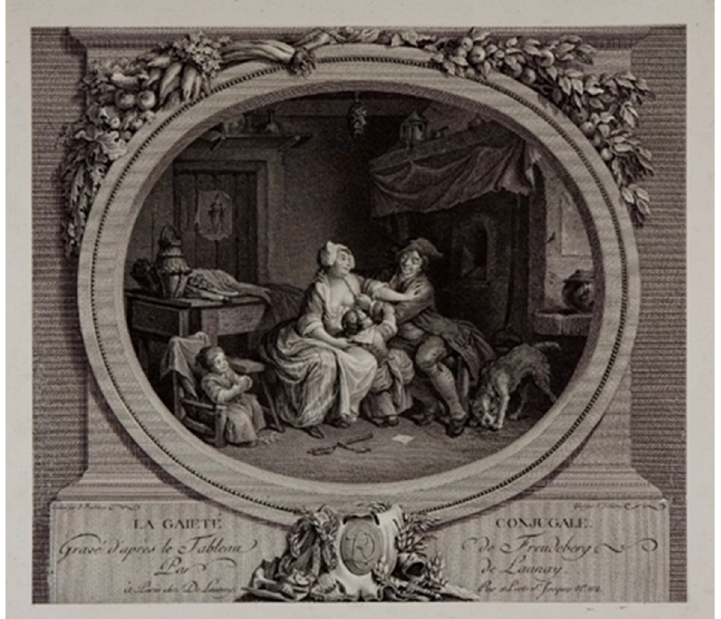
Figure 9. Nicolas Delaunay, after Sigmund Freudenberger (Switzerland 1745–1801), Conjugal Gaiety La gaieté conjugale , 1783 , Etching and engraving, 28.6 cm × 32.5 cm, Harvard Art Museums/Fogg Museum, Gift of Belinda L. Randall from the collection of John Witt Randall, R4793, Photo © President and Fellows of Harvard College.